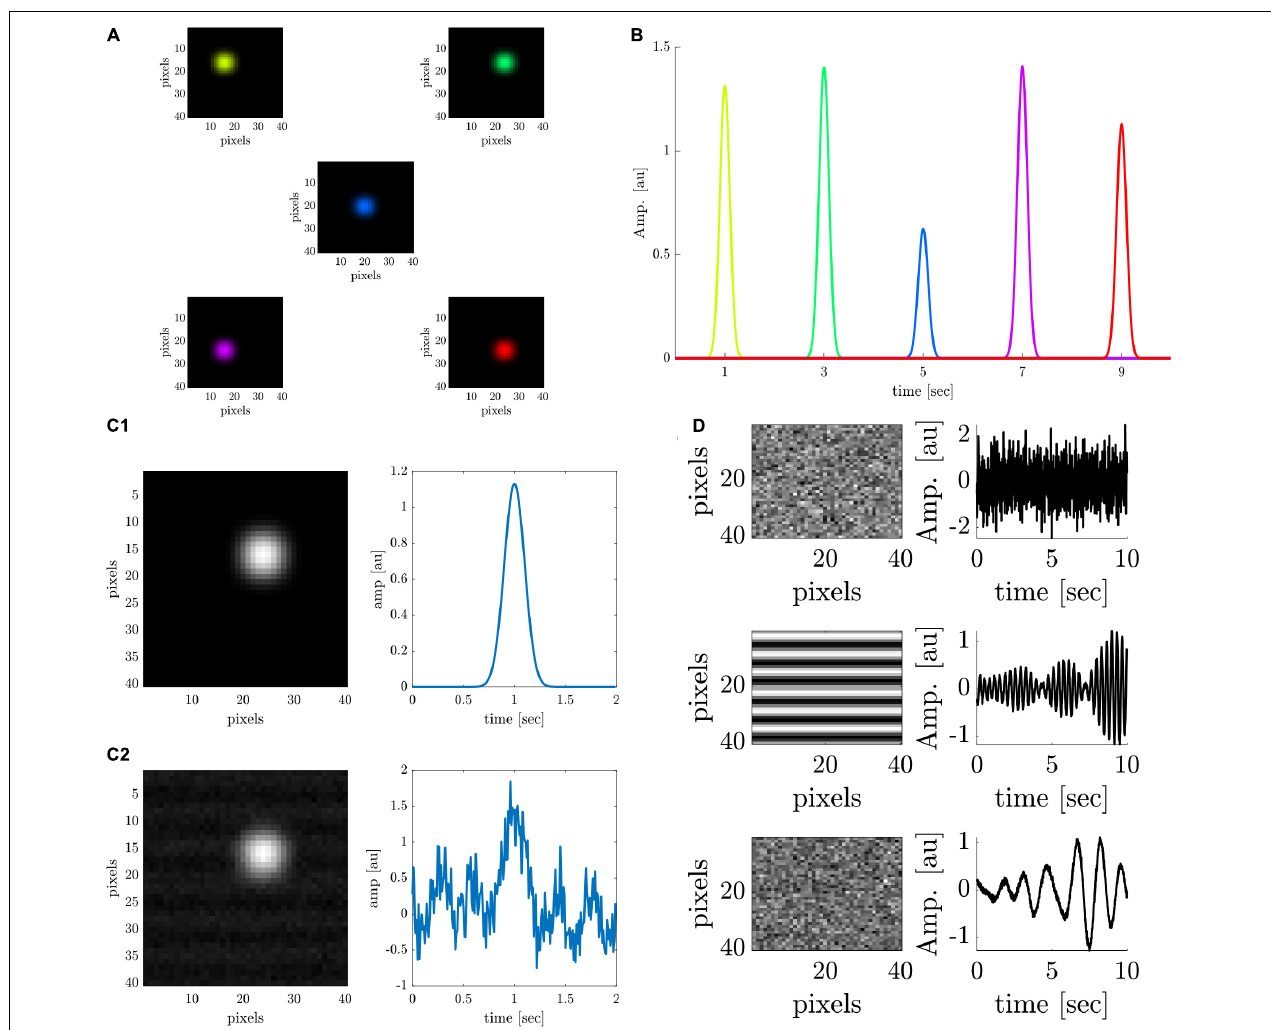
FIGURE 1 | Data analysis on stimulated cortical data. (A) Simulated spatial cortical responses at 5 different locations generated at a rate of 0.5 Hz. (B) The temporal dynamics of the 5 simulated responses elicited at a rate of 0.5 Hz (corresponding to colors in A ). (C1,C2) Upper row: A simulated cortical response without additive noise. Lower row: A simulated cortical response with additive noise (SNR = 1.5 dB). (D) Spatial and temporal components of the additive noise; upper row: Additive white noise; middle row: Additive periodic noise of 3 Hz; lower row: Additive periodic noise of 0.67